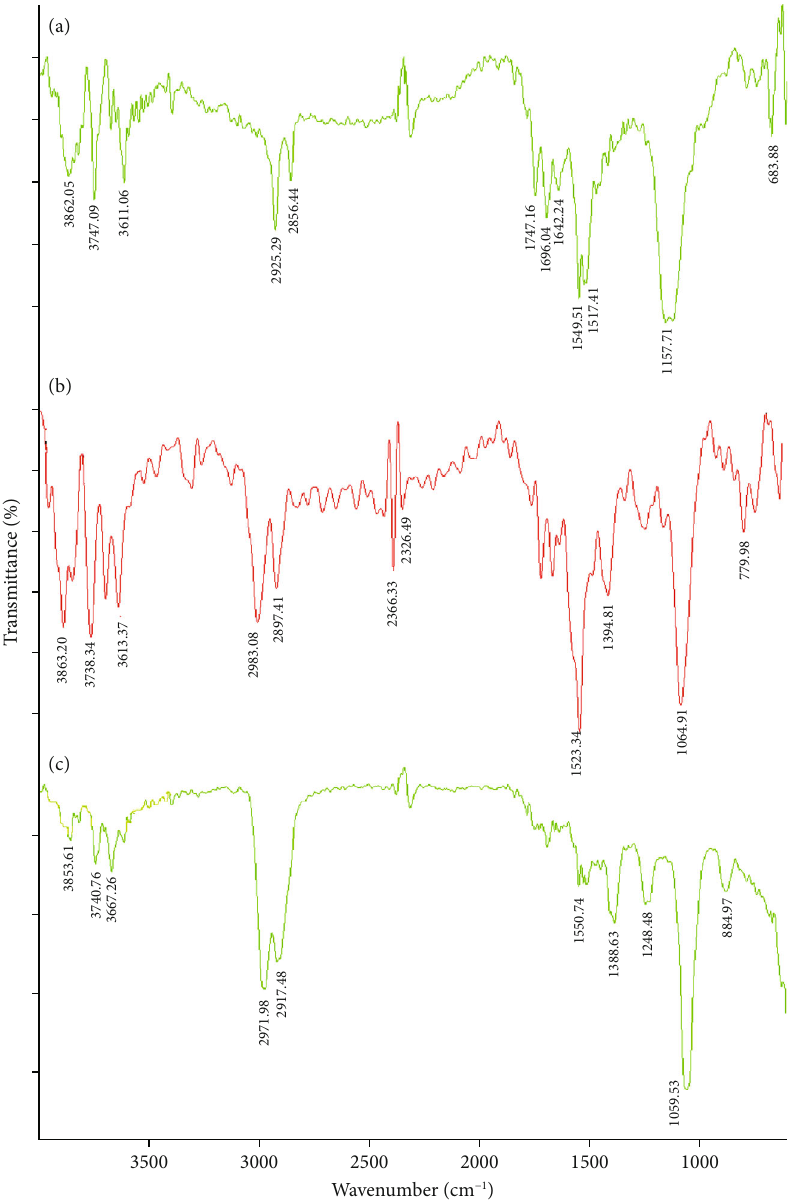
Figure 2: FT-IR spectrum of (a) HUAC, (b) HUAC-BG4, and (c)